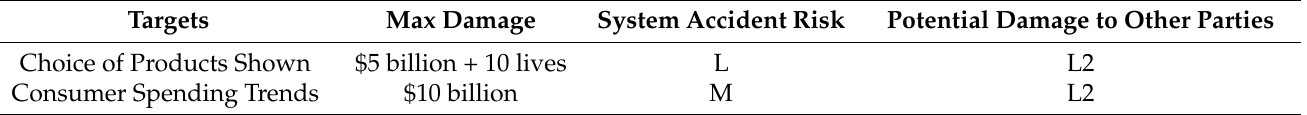
Table 12. System risks for Amazon product recommendation